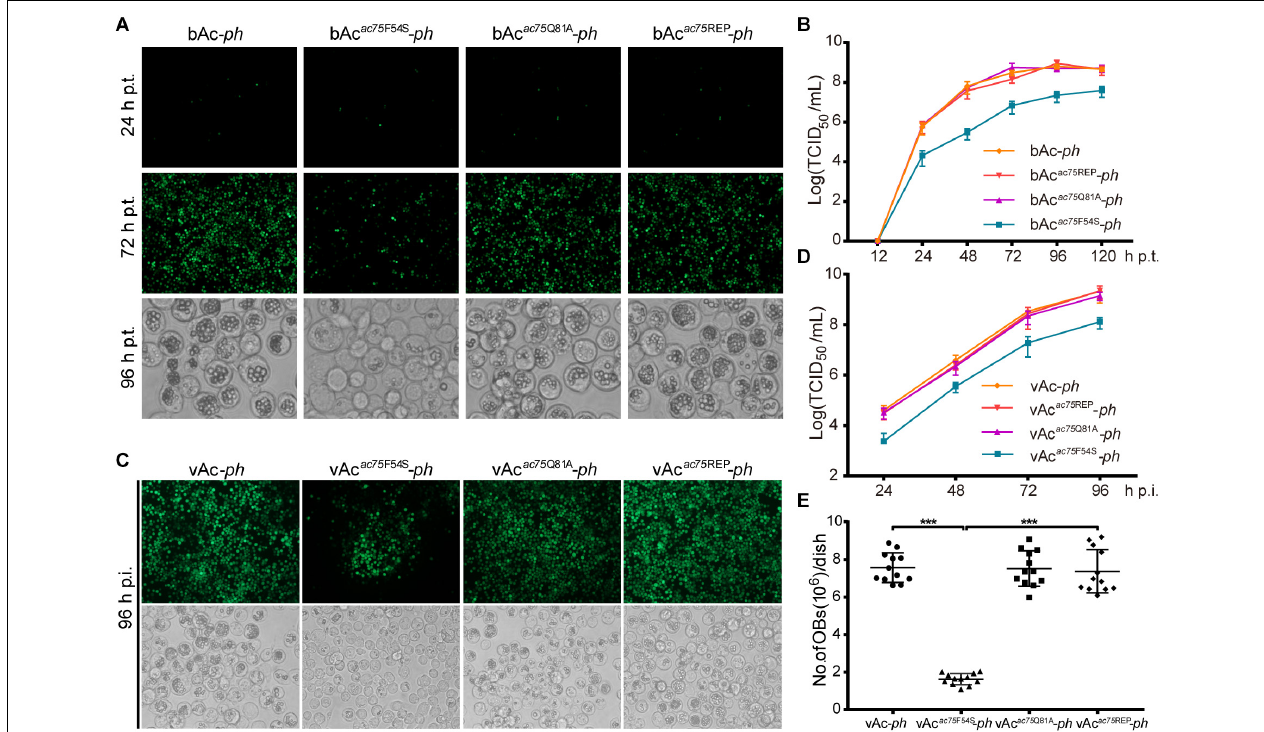
FIGURE 3 | Analyses of viral replication and OB formation in the transfected/infected cells. (A) Fluorescence and light microscopy analyses of bacmid-transfected cells. Sf9 cells were transfected with bAc- ph , bAc ac 75 F 54 S - ph , bAc ac 75 Q 81 A - ph or bAc ac 75REP - ph and imaged at 24, 72, and 96 h p.t. (B) Virus growth curves generated from bacmid-transfected cells. Sf9 cells were transfected with bAc- ph , bAc ac 75 F 54 S - ph , bAc ac 75 Q 81 A - ph , or bAc ac 75REP - ph . The supernatants were harvested at the indicated time points, and virus titers were determined by the endpoint dilution assay. Each data point represents average titers from three separate transfections. Error bars represent standard deviations (SD). (C) Fluorescence and light microscopy analyses of virus-infected cells. Sf9 cells were infected with vAc- ph , vAc ac 75 F 54 S - ph , vAc ac 75 Q 81 A - ph or vAc ac 75REP - ph (MOI = 0.5) at 96 h p.i. (D) Virus growth curves generated from virus-infected cells. Sf9 were infected with vAc- ph , vAc ac 75 F 54 S - ph , vAc ac 75 Q 81 A - ph or vAc ac 75REP - ph at an MOI of 0.5. The supernatants were harvested at the designated times and determined by the endpoint dilution assay. Each data point represents average titers from three separate infections. Error bars represent SD. (E) Amount of OB production in each dish. Sf9 cells infected vAc- ph , vAc ac 75 F 54 S - ph , vAc ac 75 Q 81 A - ph or vAc ac 75REP - ph (MOI = 10) were harvested at 96 h p.i. Total OBs of each dish were measured using a hemocytometer (*** indicates P <